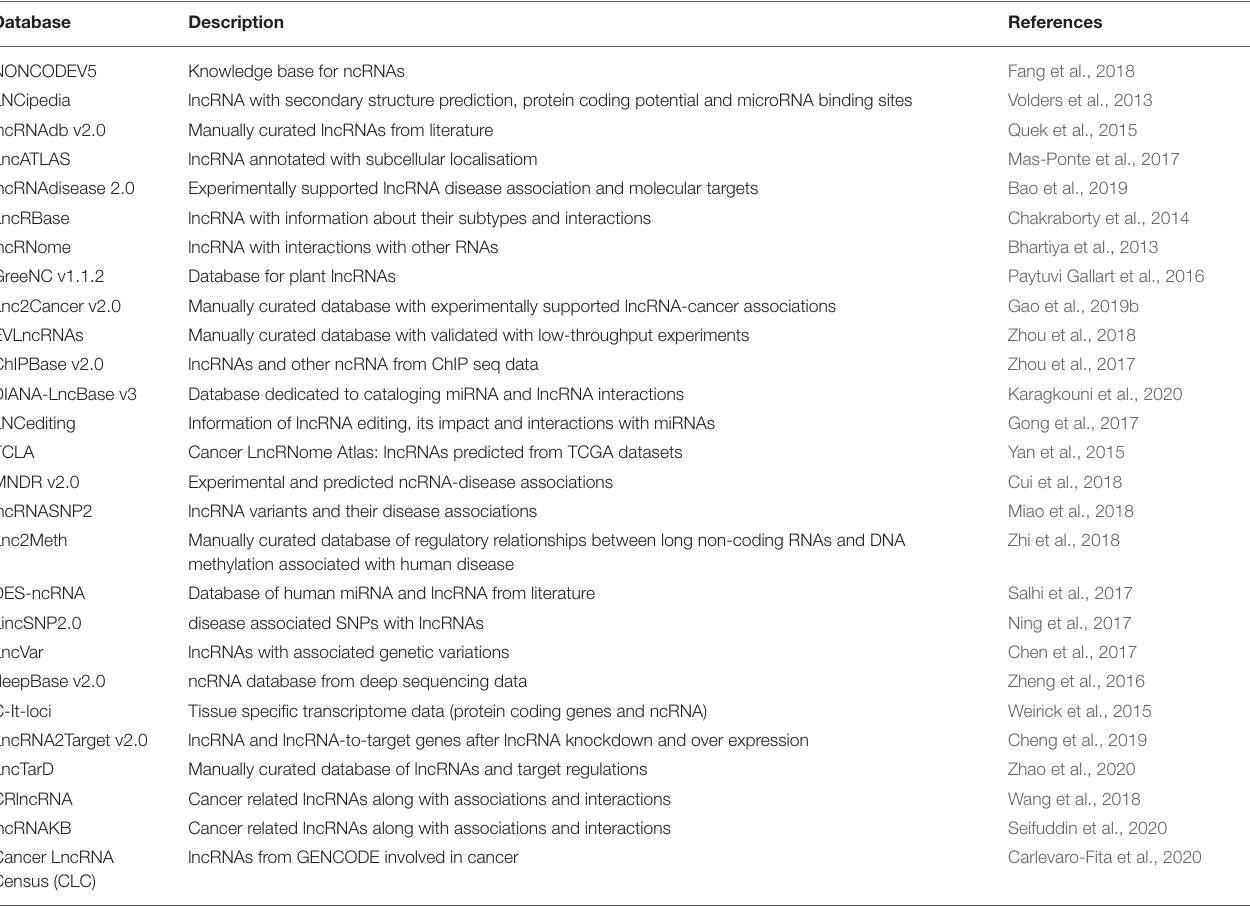
TABLE 3 | Overview of databases of LncRNAs.